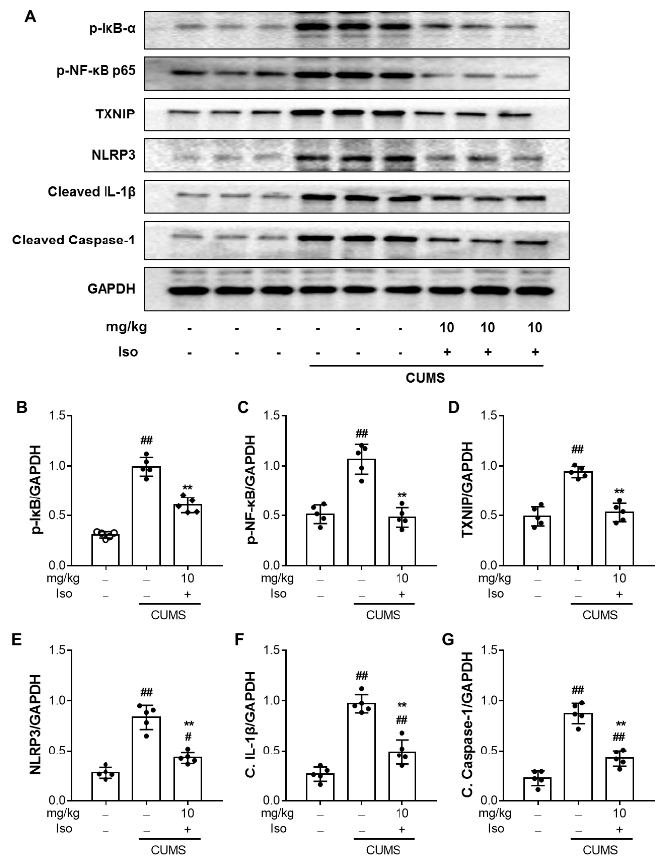
Figure 8. Isofraxidin inhibits CUMS-induced activation of NF- κ B and NLRP3 inflammasome path- ways. Level of phosphorylated I κ B α ( A , B ), phosphorylated p-NF- κ B p65 ( A , C ), TXNIP ( A , D ), NLRP3 ( A , E ), cleaved IL-1 β ( A , F ), and cleaved caspase-1 ( A , G ) in different brain samples. The pro- tein level was normalized to and expressed as folds of GAPDH. Data are presented as means ± SEM ( n = 5). The Control group was CUMS-free mice administered with normal saline. CUMS group was CUMS mice. Significance was analyzed by one-way ANOVA followed by the Bonferroni correction. # p < 0.05 and ## p < 0.01, compared with the control group. ** p < 0.01, compared with CUMS group.